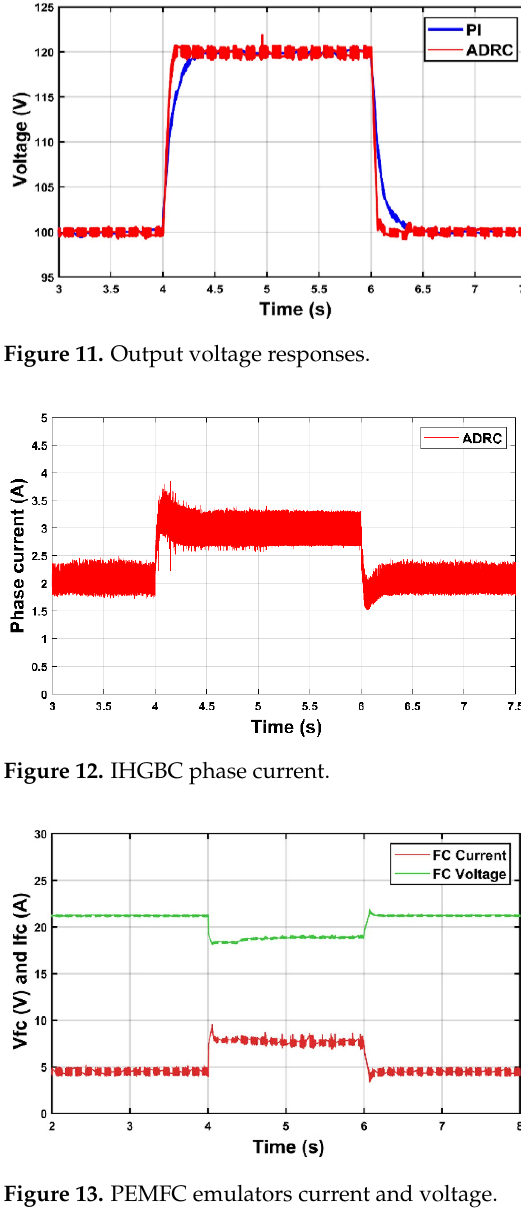
Figure 14. IHGBC phase current. Figure 15. Output voltage response.